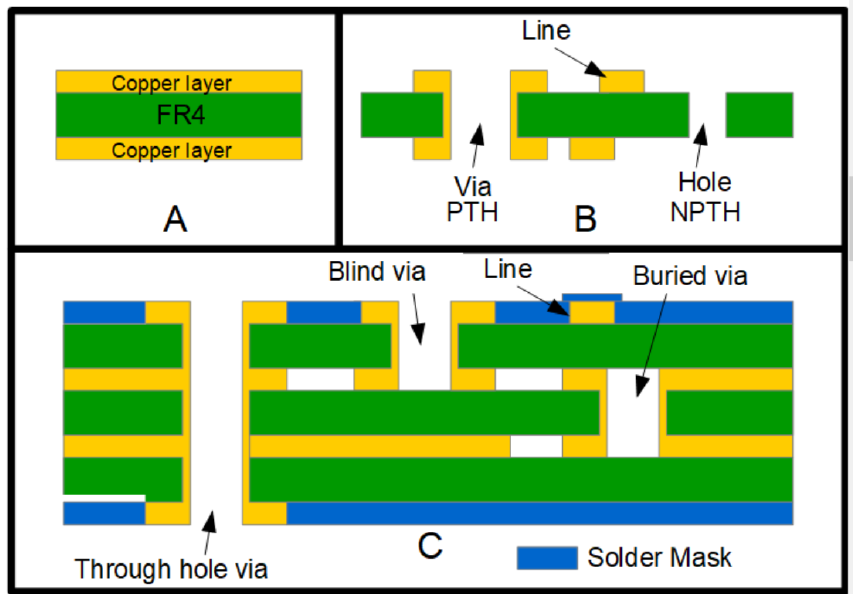
Figure 1. Cross-sectional view of a generic structure of a Printed Circuit Board (PCB). ( A ) Double-side copper layer PCB, where the Flame Retardant 4 (FR4) (green) and the metal (yellow) can be seen. ( B ) Double-side PCB with a copper line, a plated through hole (PTH) via, and a hole (non-plated through hole (NPTH)). ( C ) Four layer PCB with through hole via, blind via, buried via, and a blue solder mask covering the top and bottom